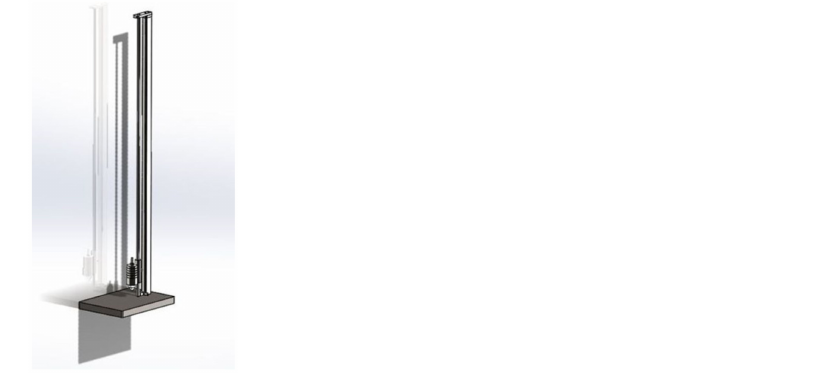
Figure 3. Schematic setup of the test rig for impact toughness